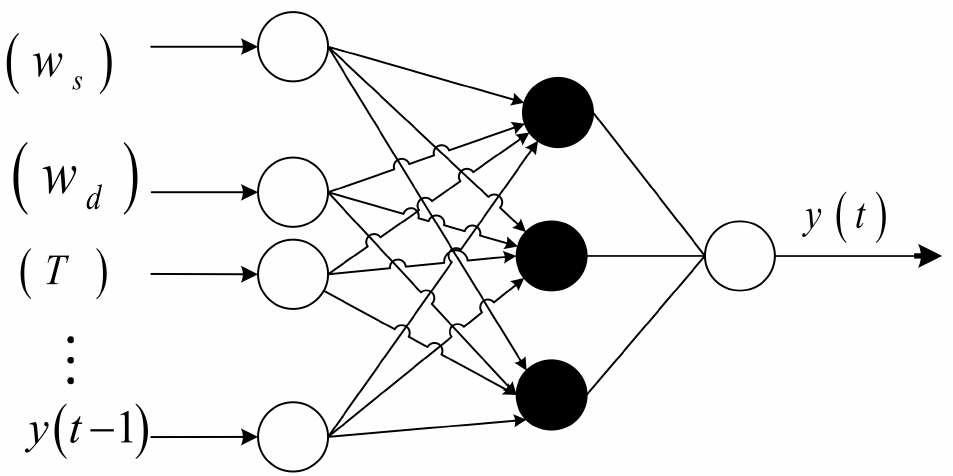
Figure 2. NN-based NARMAX Model.